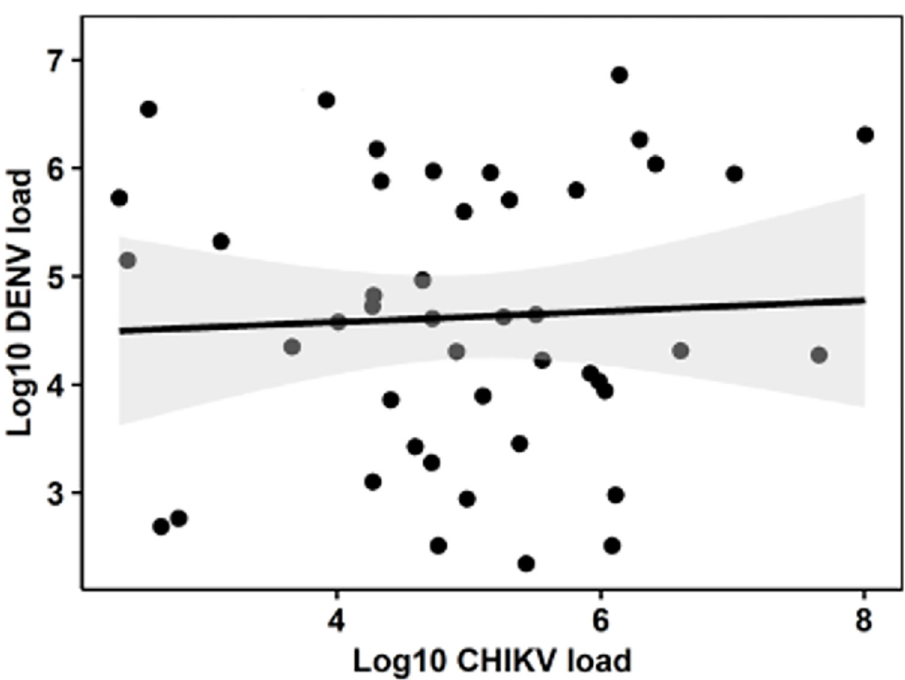
Fig 3. Scatter plot showing the relationship between mean DENV and CHIKV loads from individual families. Gray area represents the 95% confidence interval of the regression line. N = 37 mosquito families. families representing the extremes (Fig 4). The first, LOC110676965, corresponds to AAEL026917, encoding a Zinc finger-containing protein that was identified previously as upregulated in an RNAseq dataset for dengue-infected Ae . aegypti [59]. Similarly, this same gene’s expression responds to Zika infection [60]. The second locus, LOC5564245, encodes AAEL004181-PA, an uncharacterized protein. AAEL004181-PA has no previously reported phenotypes in mosquitoes but is a distant relative in a family of SGS or salivary gland-specific proteins [61]. Interestingly, this locus has been identified as a horizontally transferred gene with the insect endosymbiont, Wolbachia [61–63]. This explains why the next six hits resulting from a protein blast search [64] identify genes in several strains of Wolbachia from Culex spe- cies, Drosophila melanogaster , and Drosophila yakuba . Similarities range from 77 to 99%. While there is some controversy over the direction of the horizontal transfer, the preponder- ance of the evidence is that AAEL004181 is fundamentally a mosquito gene that was trans- ferred into Wolbachia multiple times [61,63]. In Wolbachia , there are two genes, positioned side by side in the genome (known as loci WD0512 and WD0513 in the w Mel genome [62], that together are homologous to the mosquito gene. Both WD0512 and WD0513 are actively transcribed [65], suggesting they are functional in Wolbachia .